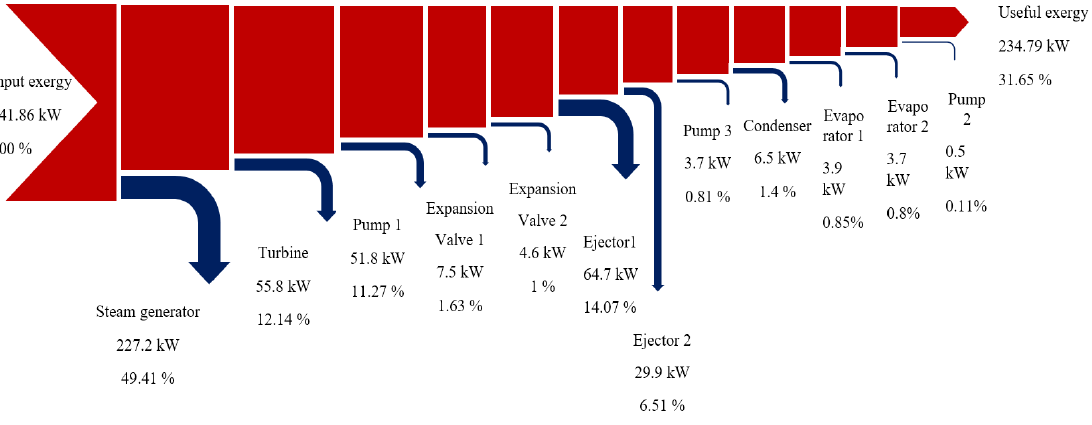
Figure 9. The exergy destruction within the group of productive and dissipative system’s components, kW.